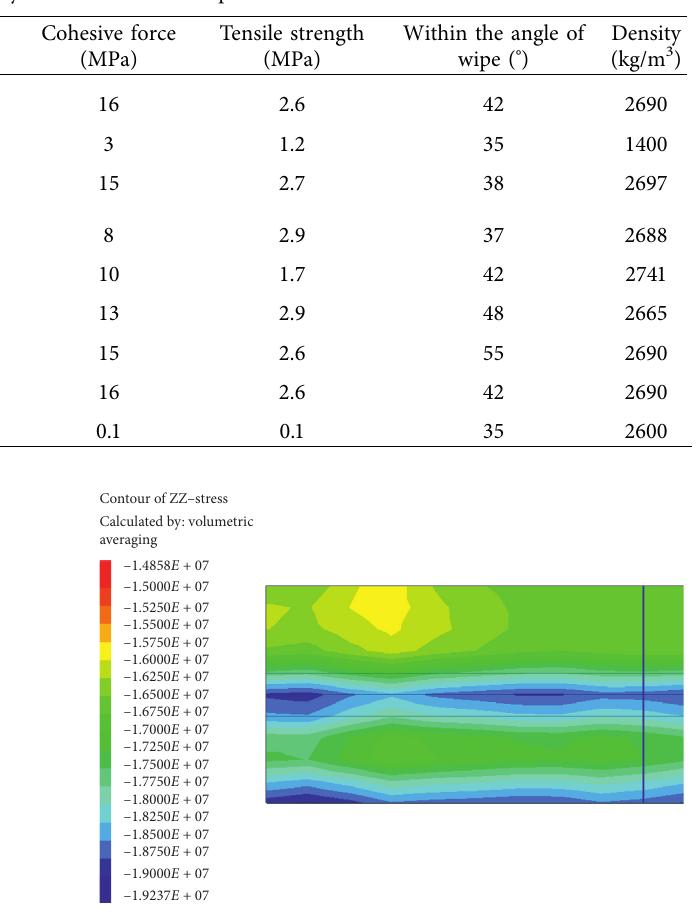
Figure 7: The vertical stress cloud diagram of the third left working face.